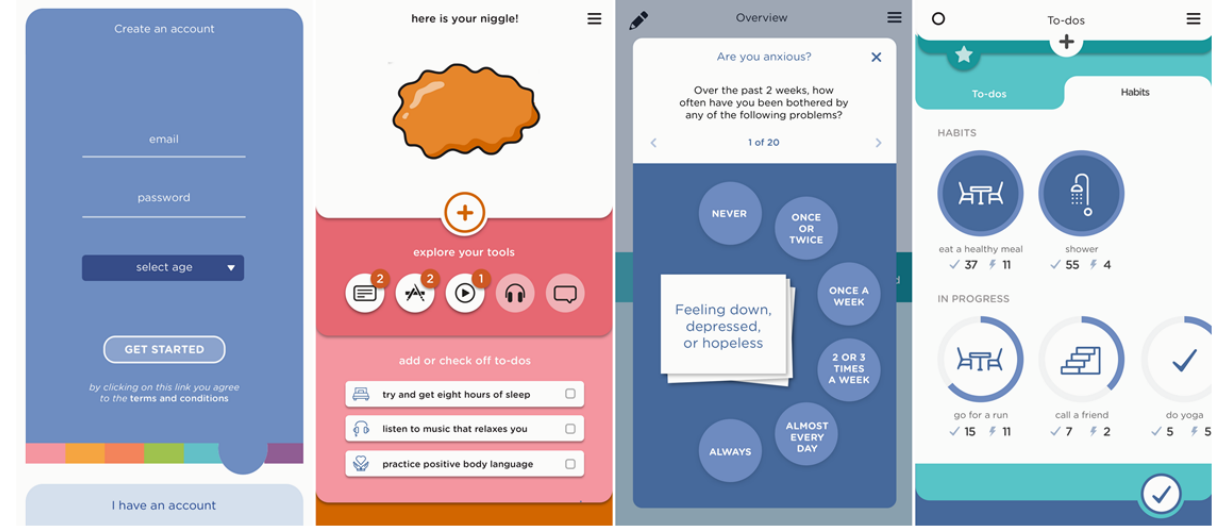
Figure 7. App features to increase